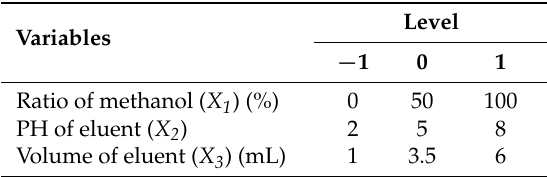
Table 5. Independent variables and their levels used for